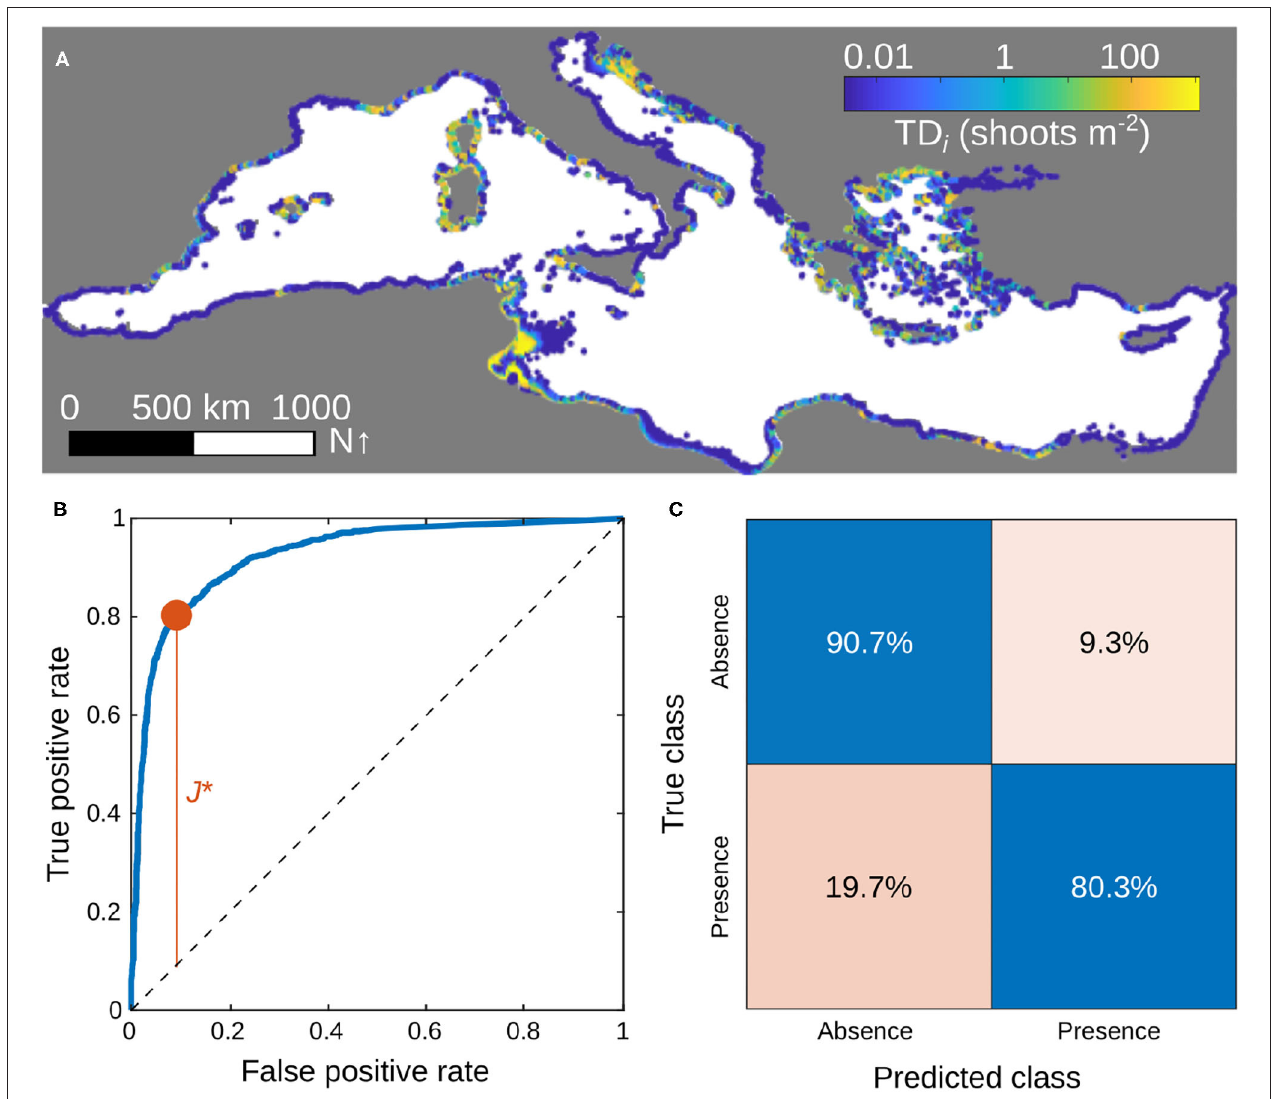
FIGURE 1 | Calibration and classification performances of the selected metapopulation model. (A) Total density of P. oceanica shoots at equilibrium, evaluated by simulating the best-performing metapopulation model over a timespan of 100 years starting from random initial conditions and using the time-averaged connectivity scores h C ij i . (B) ROC curve (in blue) of the model, evaluated as a classifier of the binary presence/absence P. oceanica data. The red dot identifies the threshold for which Youden’s J -statistics is maximum. The dashed diagonal represents the line of no-discrimination, corresponding to the performance of a random binary classifier. (C) Confusion matrix evaluated for the discrimination threshold maximizing Youden’s J . Calibrated parameter values: δ σ = δ g = δ f = 1.11 · 10 − 3 (shoots m − 2 ) − 1 , δ h = 0. Other parameters as in Table 1